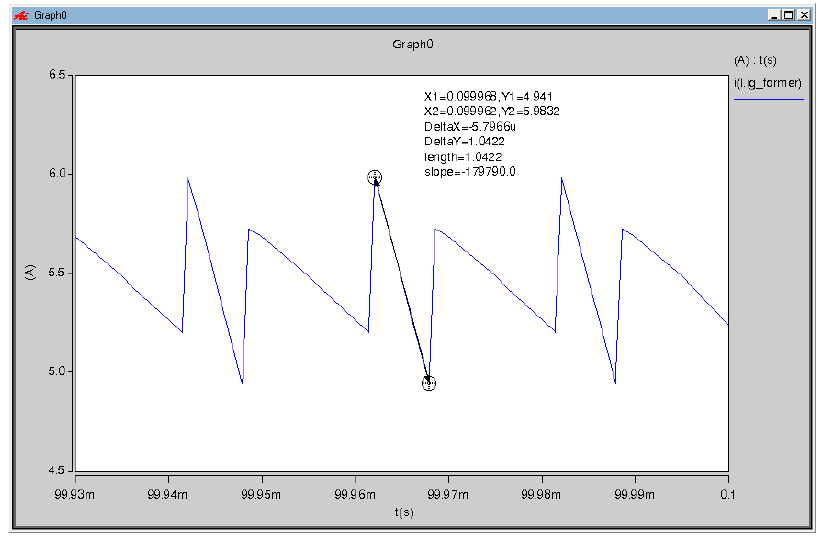
Figure 14. Zoom in the input current ripple for the former strategy when G = 5, D = 0 . 7101 ( k d